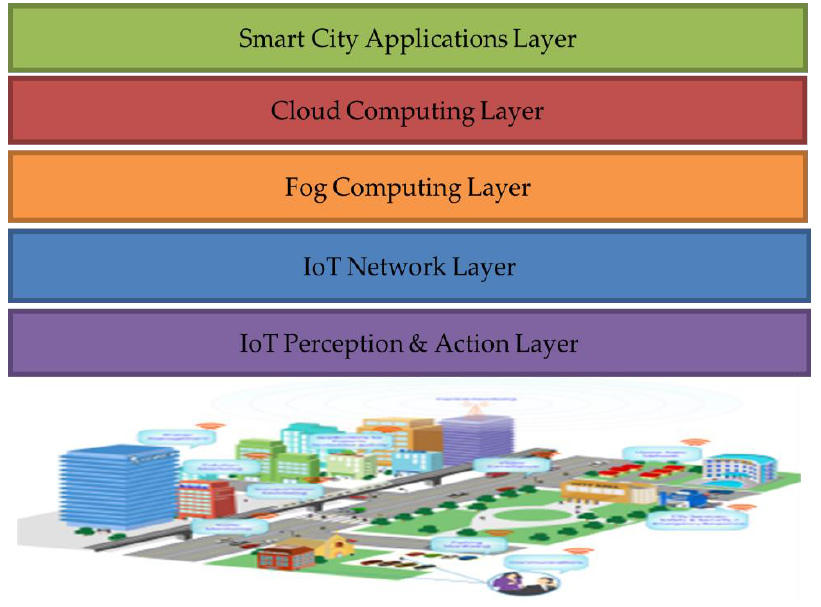
Figure 4. iIFCs layers for smart city applications.